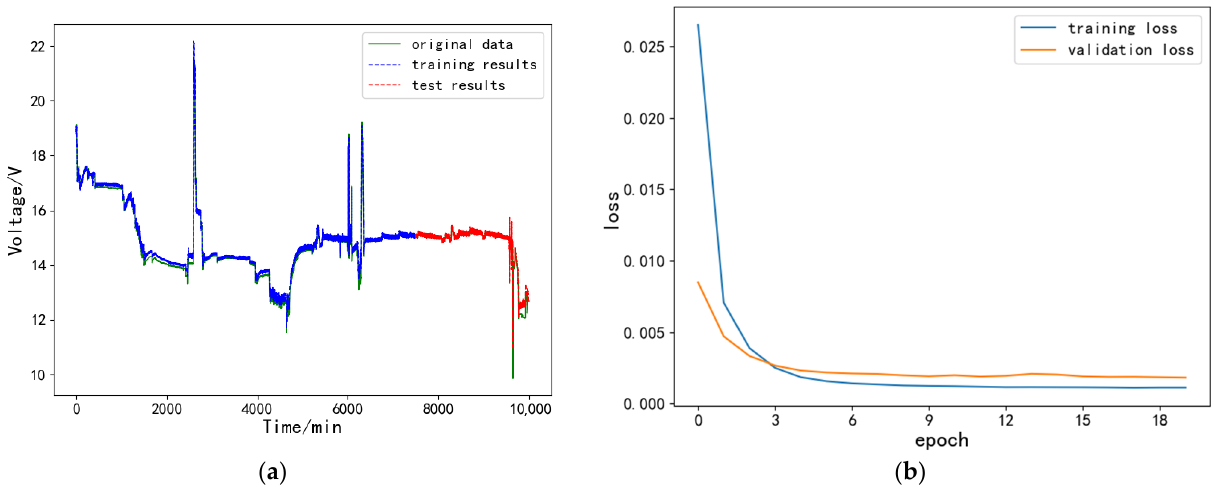
Figure 10. Prediction results of original LSTM model. ( a ) Model training and prognosis results; ( b ) training loss during the training